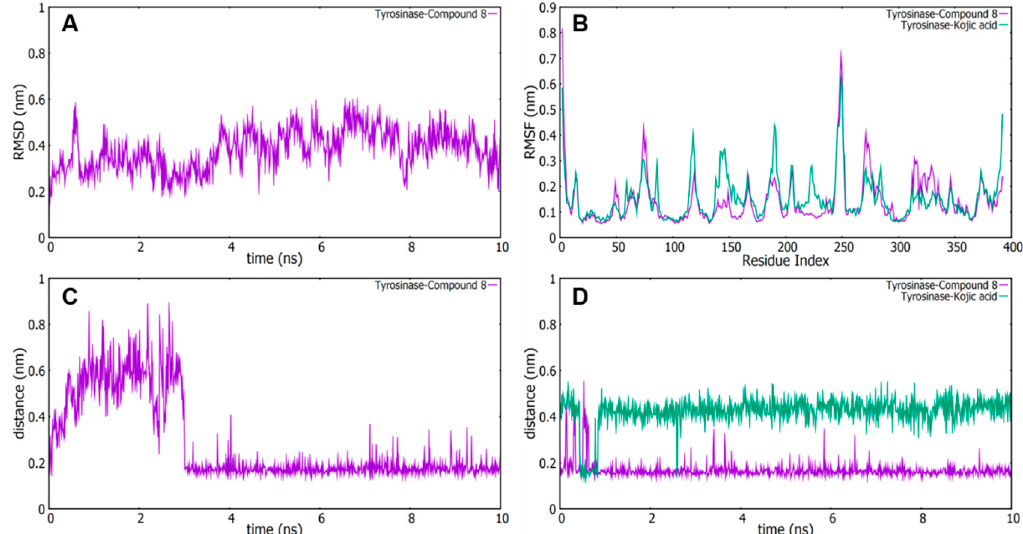
Figure 4. Molecular dynamics (MD) simulation results. Root mean square deviation (RMSD) time profiles of compound 8 during the MD simulations ( A ). Root mean square fluctuation (RMSF) curve of the residues (sequence 0–400) of compound 8 and kojic acid during the MD simulation ( B ). The time profile of the distance between ASN260 in compound 8 ( C ) and MET280 in compound 8 or kojic acid ( D ), respectively.